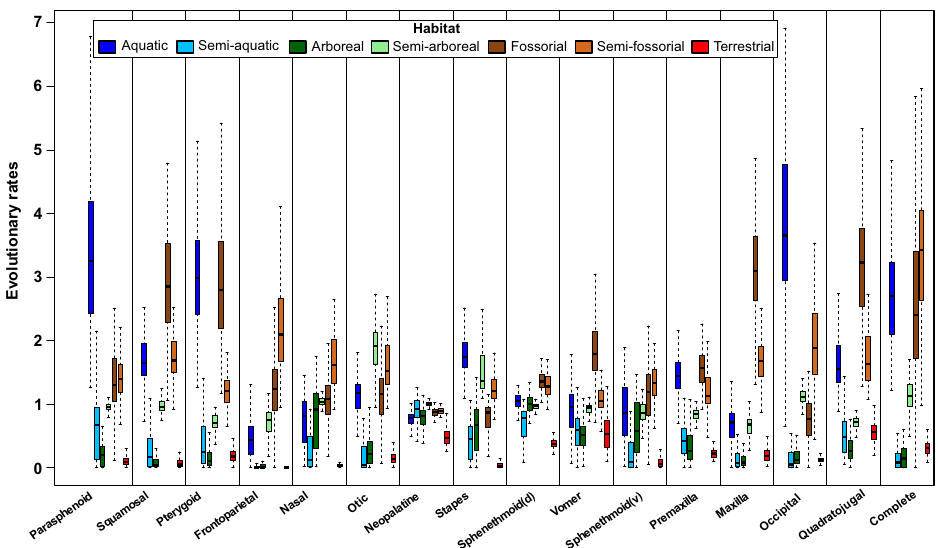
Fig. 5 Region-speci fi c rates of evolution for different microhabitats. Evolutionary rate for each of the 15 cranial regions and the cranium across different microhabitats estimated across a random sample of 100 trees drawn in the posterior distribution of Jetz and Pyron 113 . Intraspeci fi c variation and measurement error were jointly estimated along with evolutionary rates during model fi t to account for uncertainty in traits values that cmay cause model departure. Rates are standardised by the mean, and box bounds represent the median with the fi rst and third quartile, while whiskers indicate the minimum and maximum values within 1.5x the interquartile range.